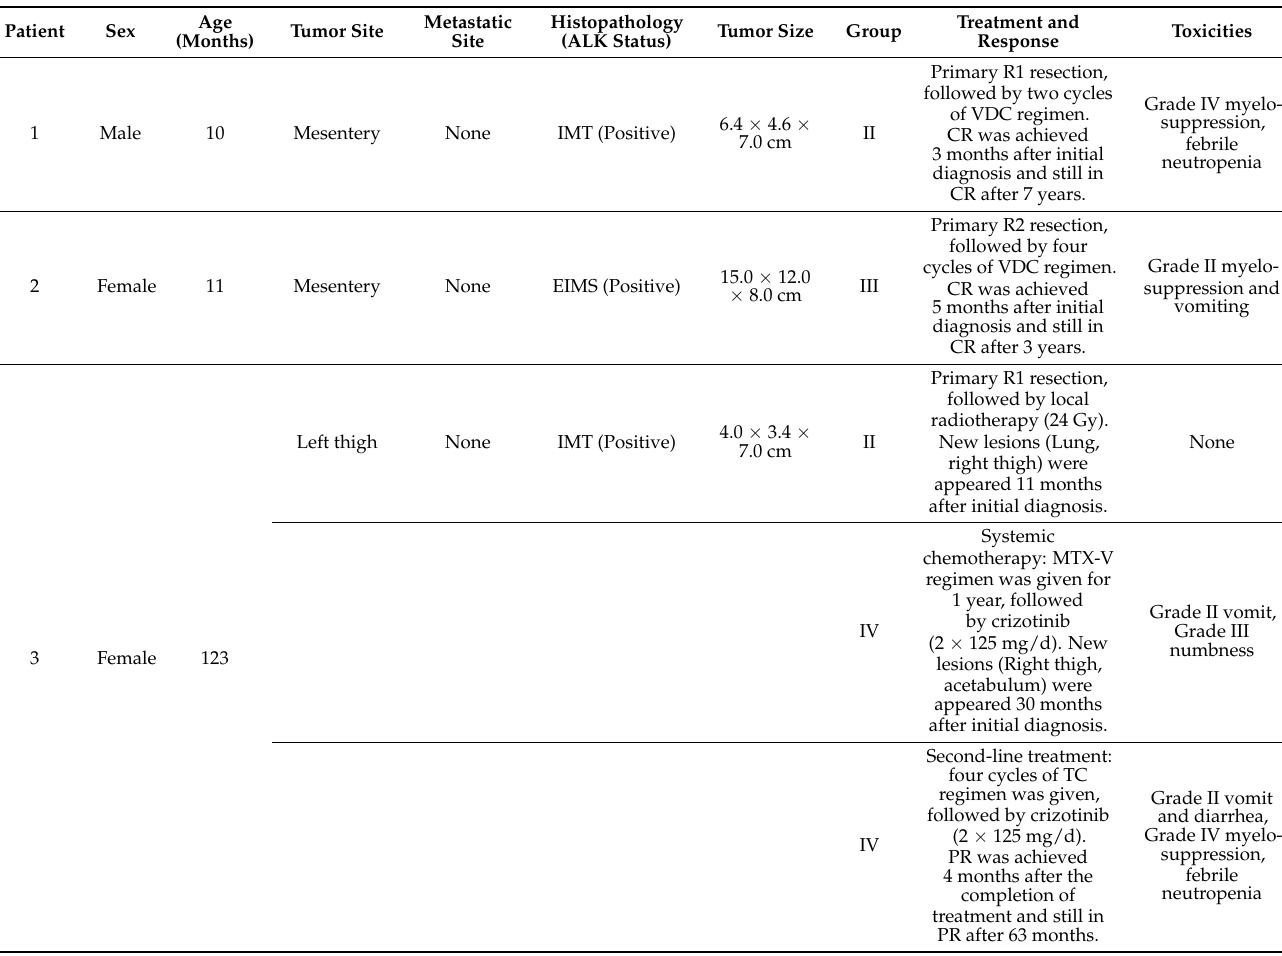
Table 2. Clinical characteristics, treatment-related toxicities and treatment response of 6 patients with inflammatory myofibroblastic tumor